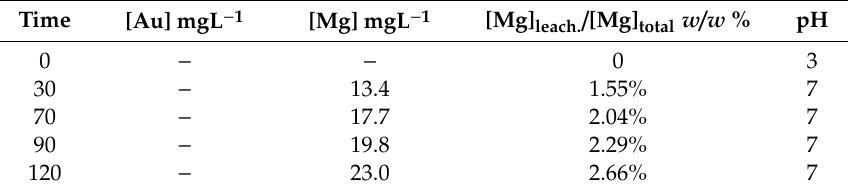
Table 4. ICP-OES analyses and pH of the reaction samples.